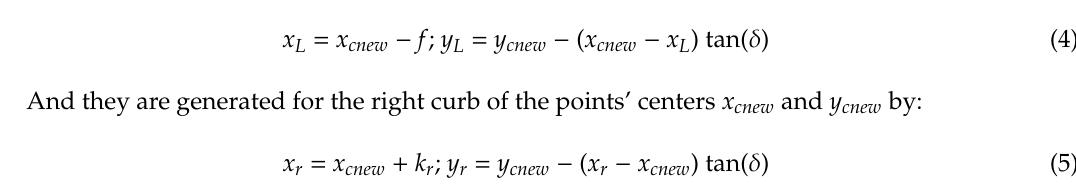
Detecting of the Curbs in the Right and Left